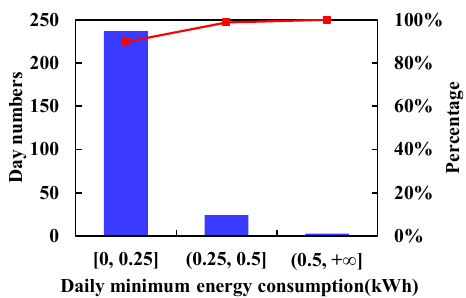
Figure 2. Pareto chart of daily minimum energy consumption.